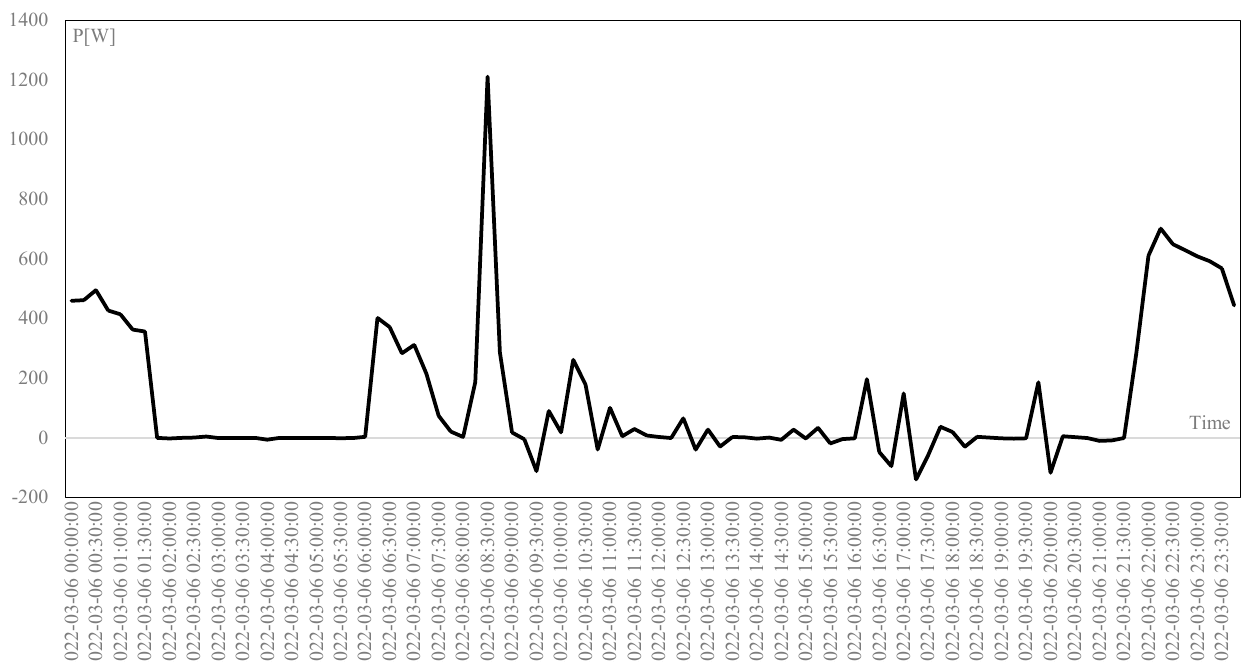
Figure 13. Exchanged grid net power.